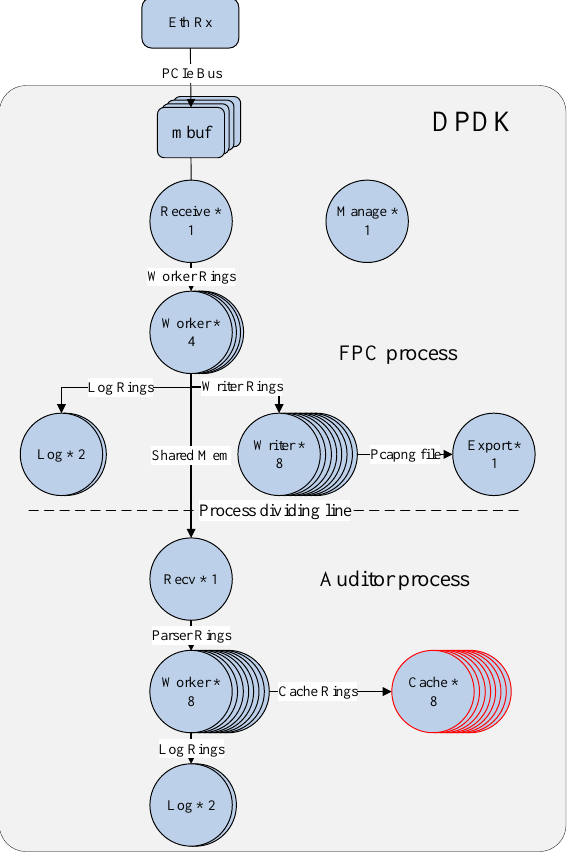
Figure 1. System design